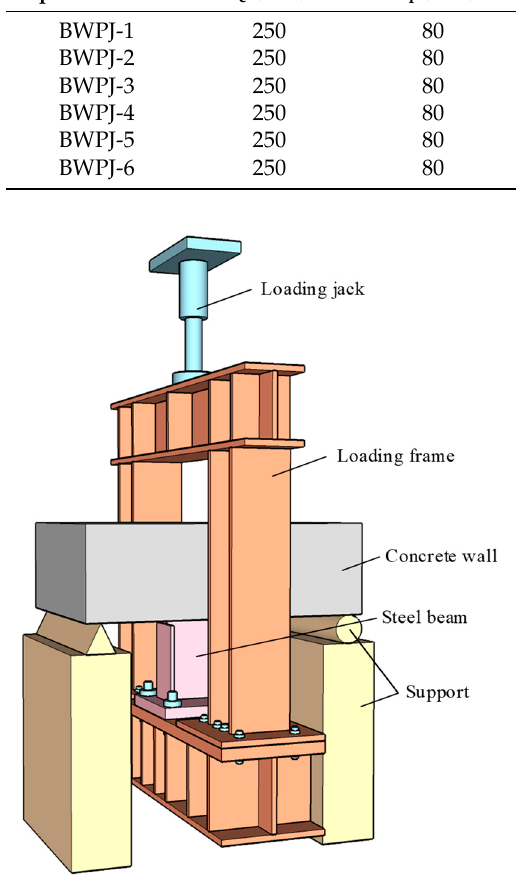
Figure 3. Geometric information of SBCW joints (unit: mm). Table 1. The investigated parameters of the tested SBCW joint specimens [17]. Specimen No.